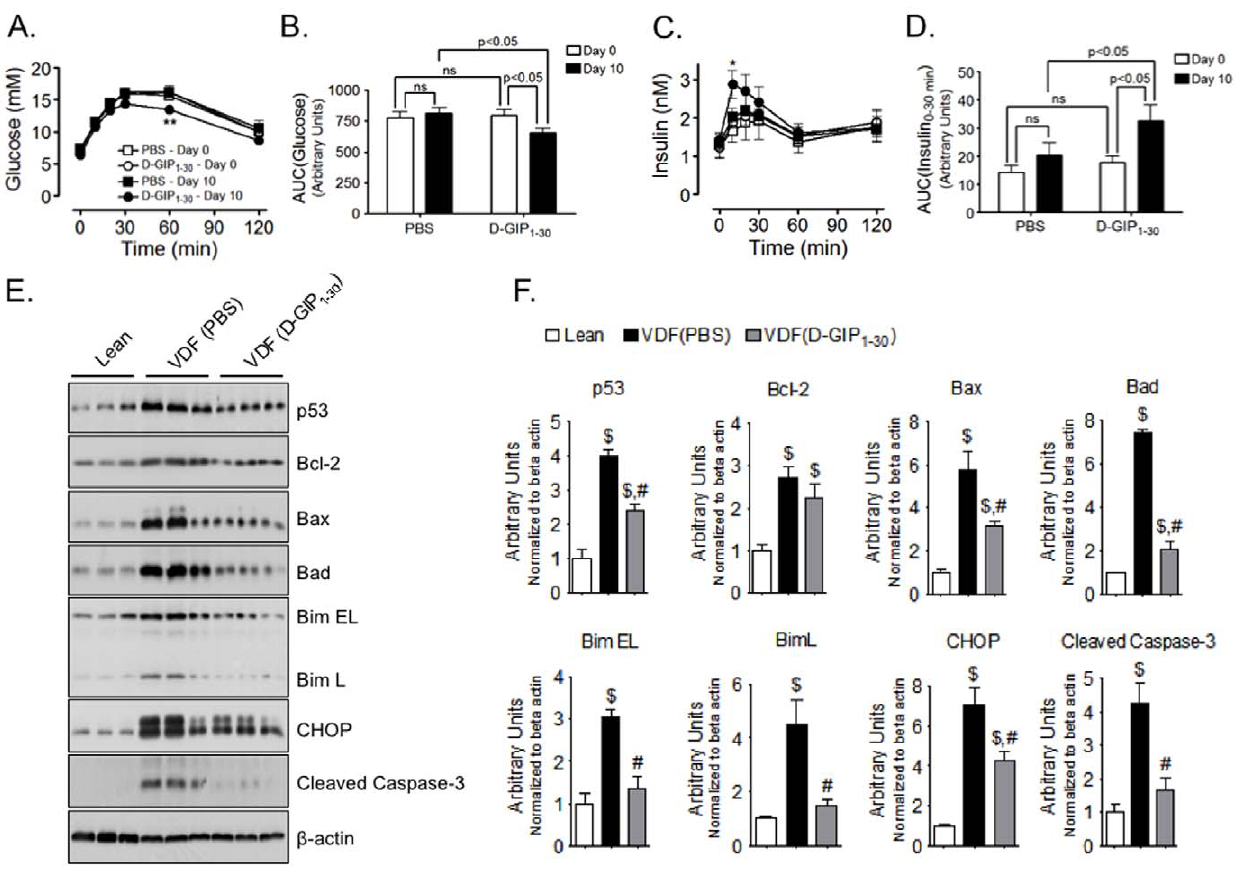
Figure 3. D-GIP 1–30 improves islet function and diminishes islet pro-apoptotic protein levels in VDF rats. A , OGTTs were performed on obese VDF rats , 24 h prior to and , 48 h following 10 days of twice daily treatment with PBS or D-GIP 1–30 (8 nmol/kg BW) and blood glucose levels measured. Mean 6 SEM (n=6); **, p , 0.01 vs same VDF rats prior to treatment. B , Integrated glucose profile for OGTTs described in A . Mean 6 SEM (n=6); significant differences as shown. C , Insulin levels were determined from blood samples collected in A . Mean 6 SEM (n=6); *, p , 0.05 vs same VDF rats prior to treatment. B , Integrated acute insulin response (from 0 to 30 minutes) for insulin profiles described in C . Mean 6 SEM (n=6); significant differences as shown. E , Islets were isolated from VDF rats and age matched Lean rats , 24 h following OGTTs and Western analysis performed on cell lysates with indicated antibodies. F , For quantification, protein levels were normalized to beta-actin and expressed relative to Lean controls. Mean 6 SEM (n=3); $, p , 0.05 vs Lean; # , p , 0.05 vs VDF